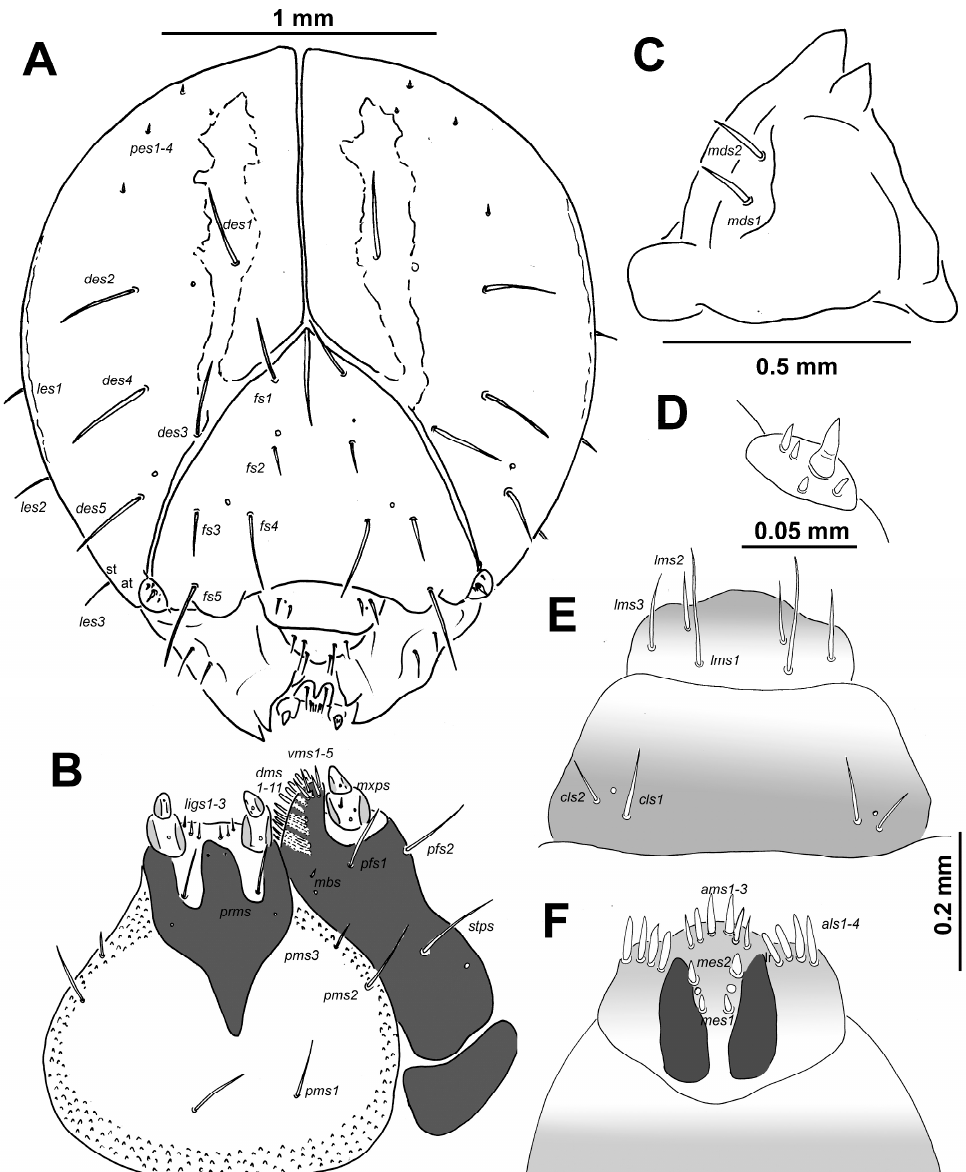
Figure 2. Cleonis pigra mature larva, head, antenna, and mouth parts. ( A )—dorsal view ( des —dorsal epicranial seta (e), fs —frontal epicranial s., les —lateral epicranial s., ves —ventral epicranial s., st—stemmata, at—antenna); ( B )—right maxilla, dorsal view ( dms —dorsal malar s., vms —ventral malar s., mpxs —maxillary palps s., mbs —basoventral s., pfs —palpiferal s., stps —stipital s.), prementum and postmentum, ventral view ( prms —premental s., pms —postmental s., ligs —ligular s.); ( C )—right mandible ( mds —mandible dorsal s.); ( D )—antenna; ( E )—labrum and clypeus ( cls —clypeal s., lms —labral s.); ( F )—epipharynx ( ams —anteromedial s., als —anterolateral s., mes —median s., lr—labral